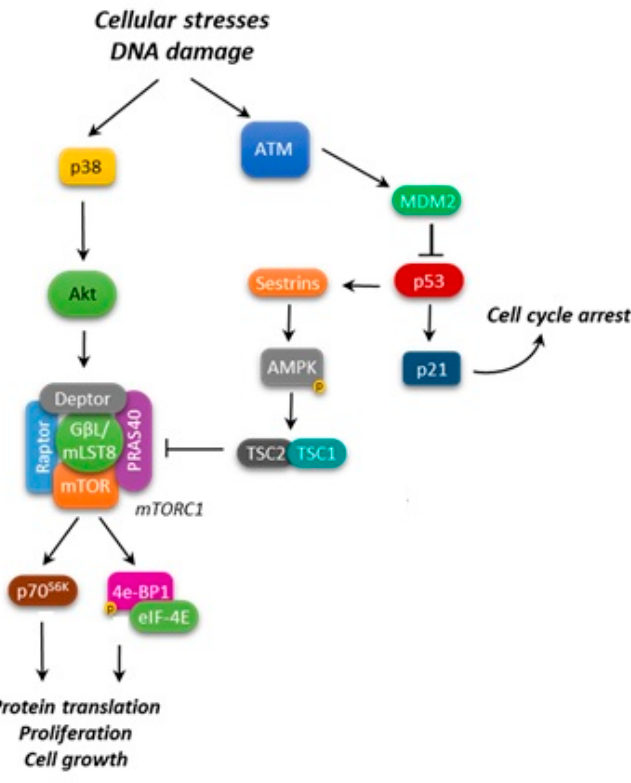
Figure 2. p53 and mTORC1 interaction. Arrows: positive interaction; T-bars: inhibition.